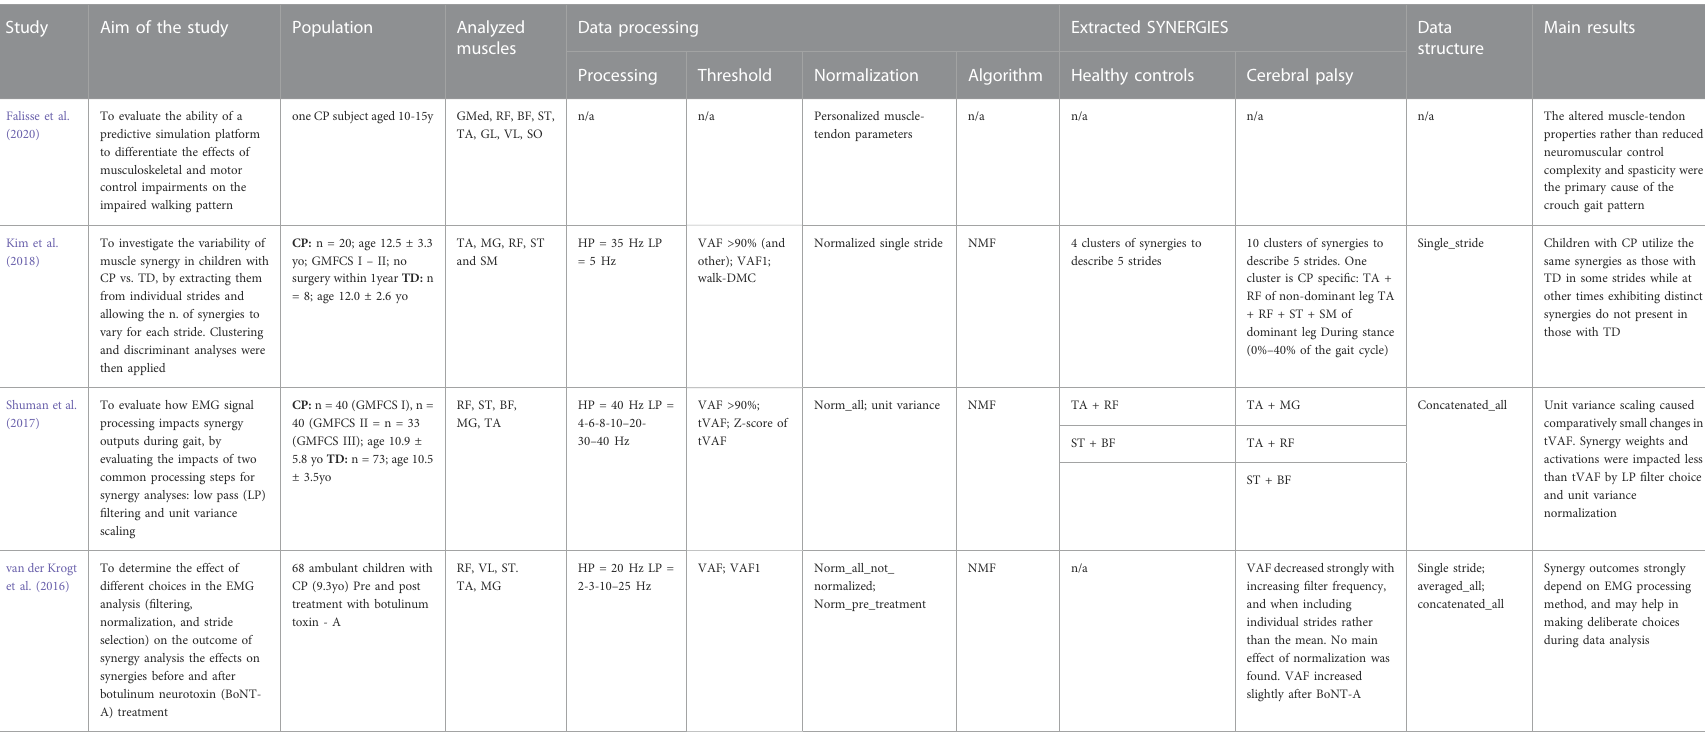
TABLE 1 ( Continued ) Aim of the study, population, analyzed muscles, data processing, data structure, extracted synergies, main results of the articles investigating how muscle synergies vary in children affected by Cerebral Palsy (CP) in respect to healthy subjects. Acronyms: CP: cerebral palsy, TD: typically developed, HC: healthy controls, GMFCS: Gross Motor Function Classi fi cation System, BW: backward walking, FW: forward walking,